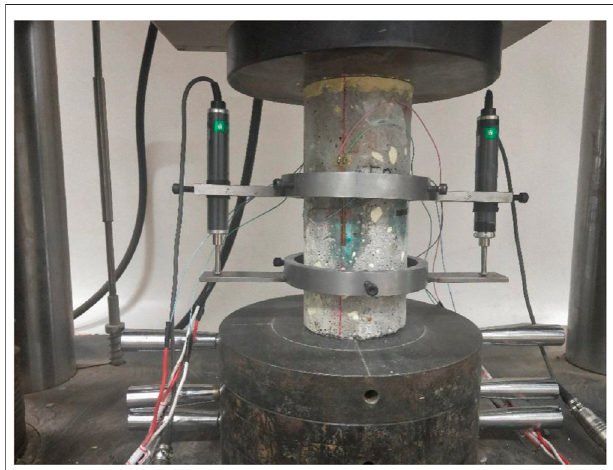
FIGURE 2 | Test setup and